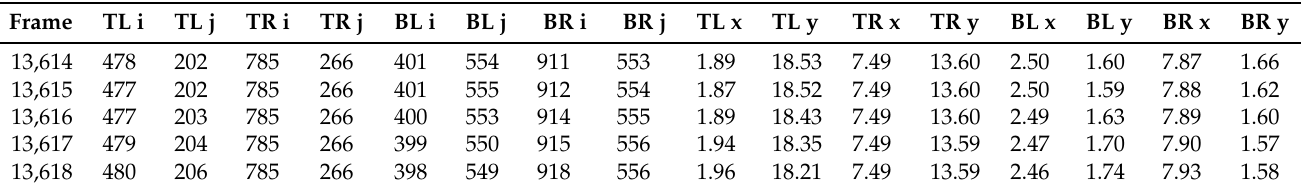
Table 3. Example of raw tabular data for the frames of a video. Players are referred to with their location in the video at serve time (e.g. TL means top-left player). Positions are given in image space ( i , j are in pixels) and court-space ( x , y are in